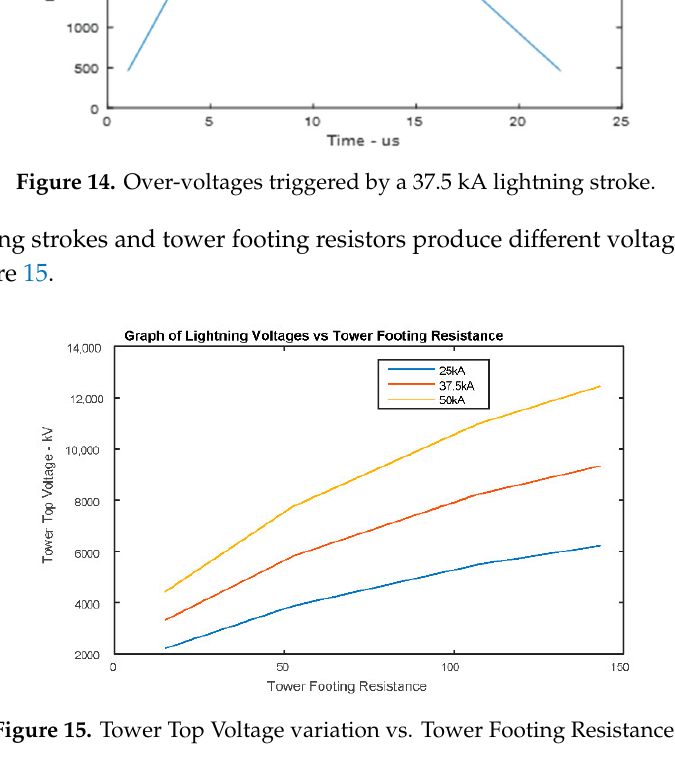
Figure 16. Enhance earthing (less than 30 ohms) vs. overvoltages.